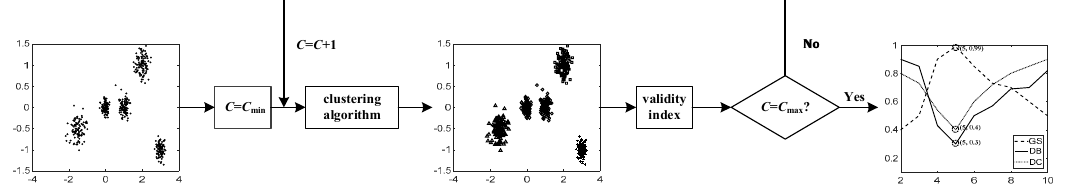
Figure 3. Evaluation processes of three existing validity indices.